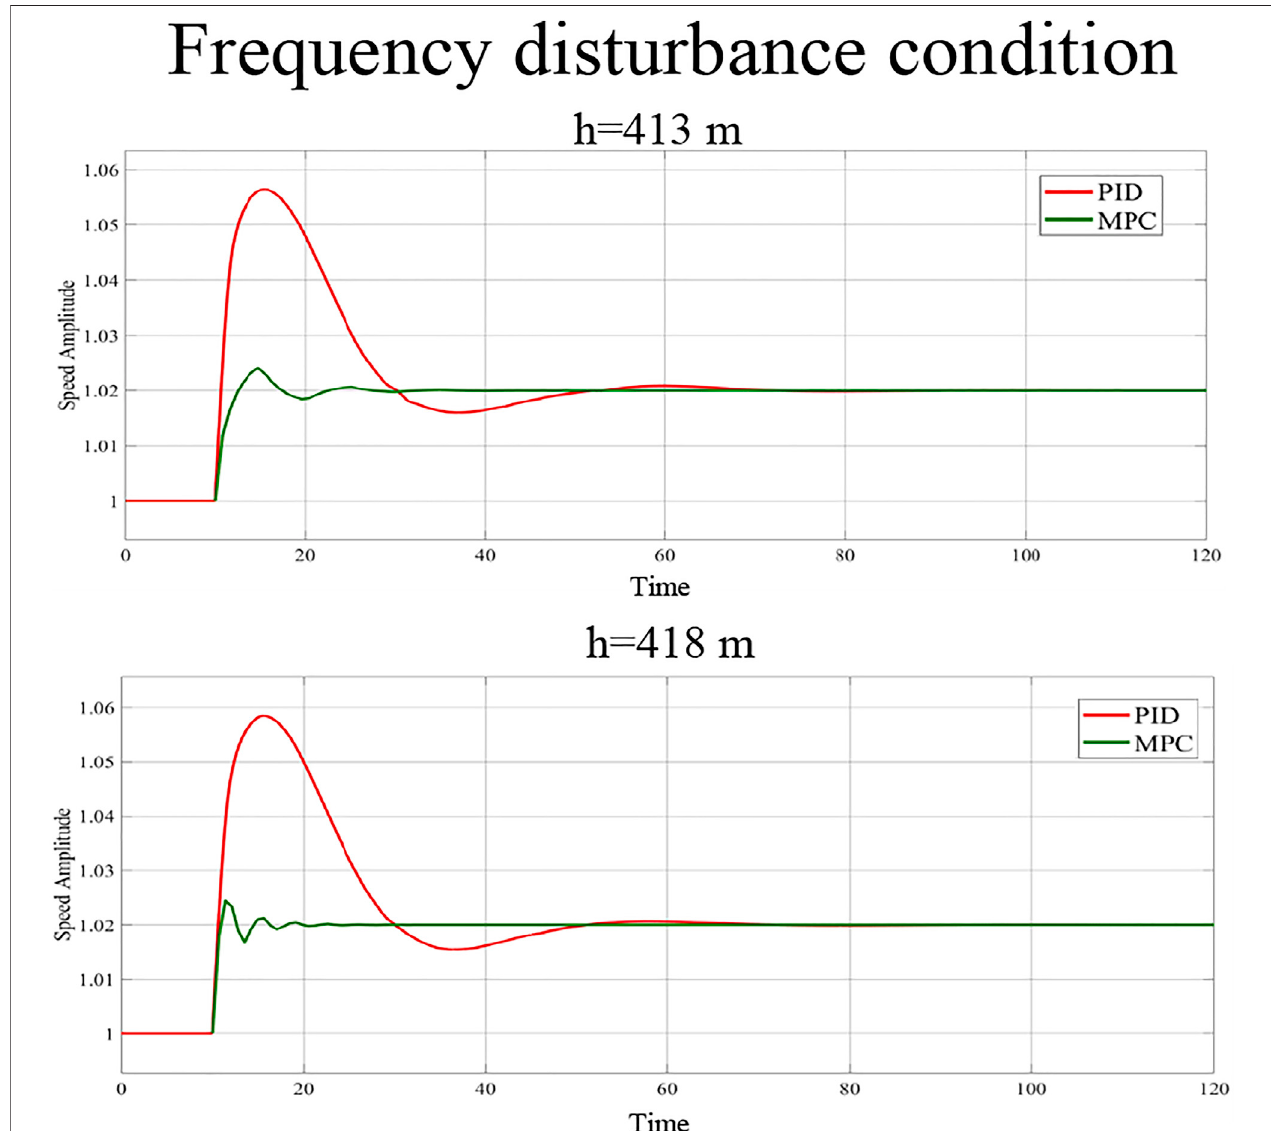
FIGURE 11 | Speed variation in the presence of a frequency disturbance under 413 and 418 m of water head.